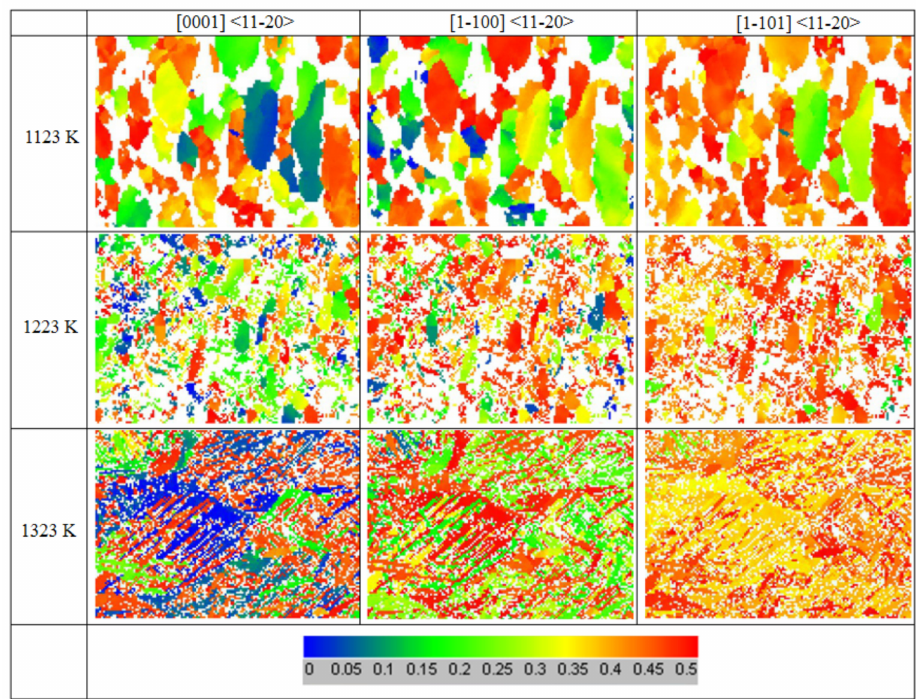
Figure 8. The Schmidt factors of Ti-6.5Al-3.5Mo-1.5Zr-0.3Si alloy after deformation under various